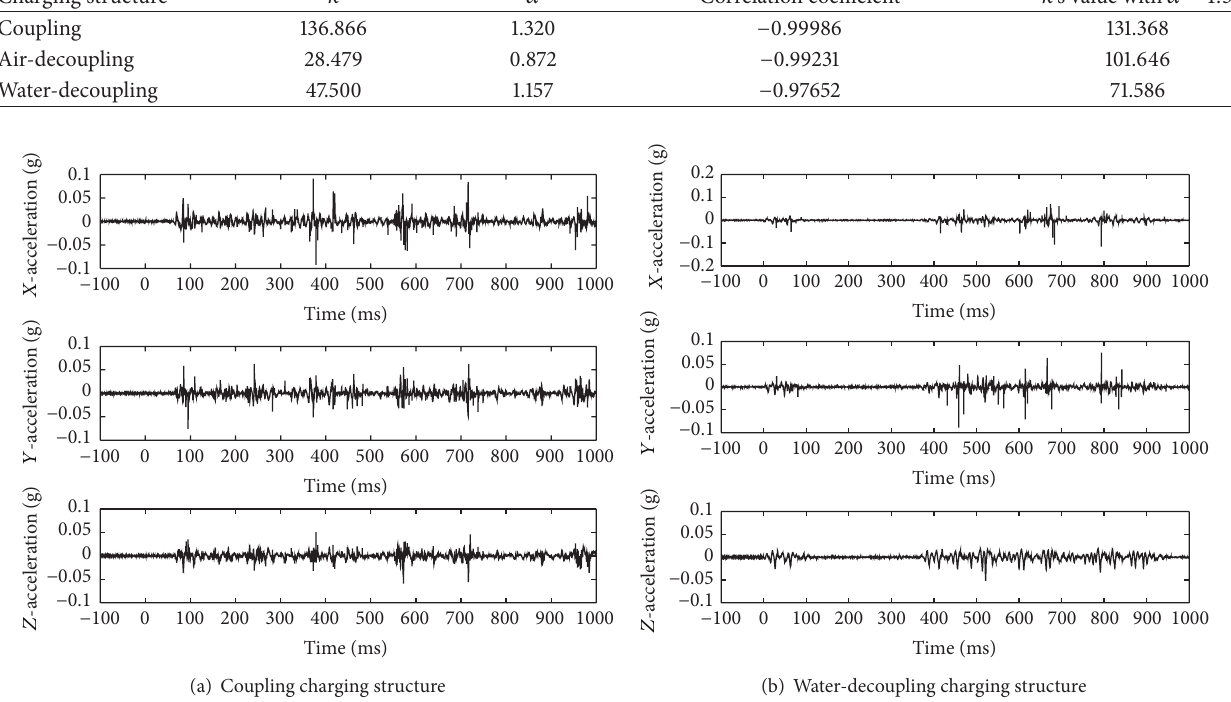
(b) Water-decoupling charging structure Figure 5: Schedule chart of different charging structures’ vibration acceleration in three